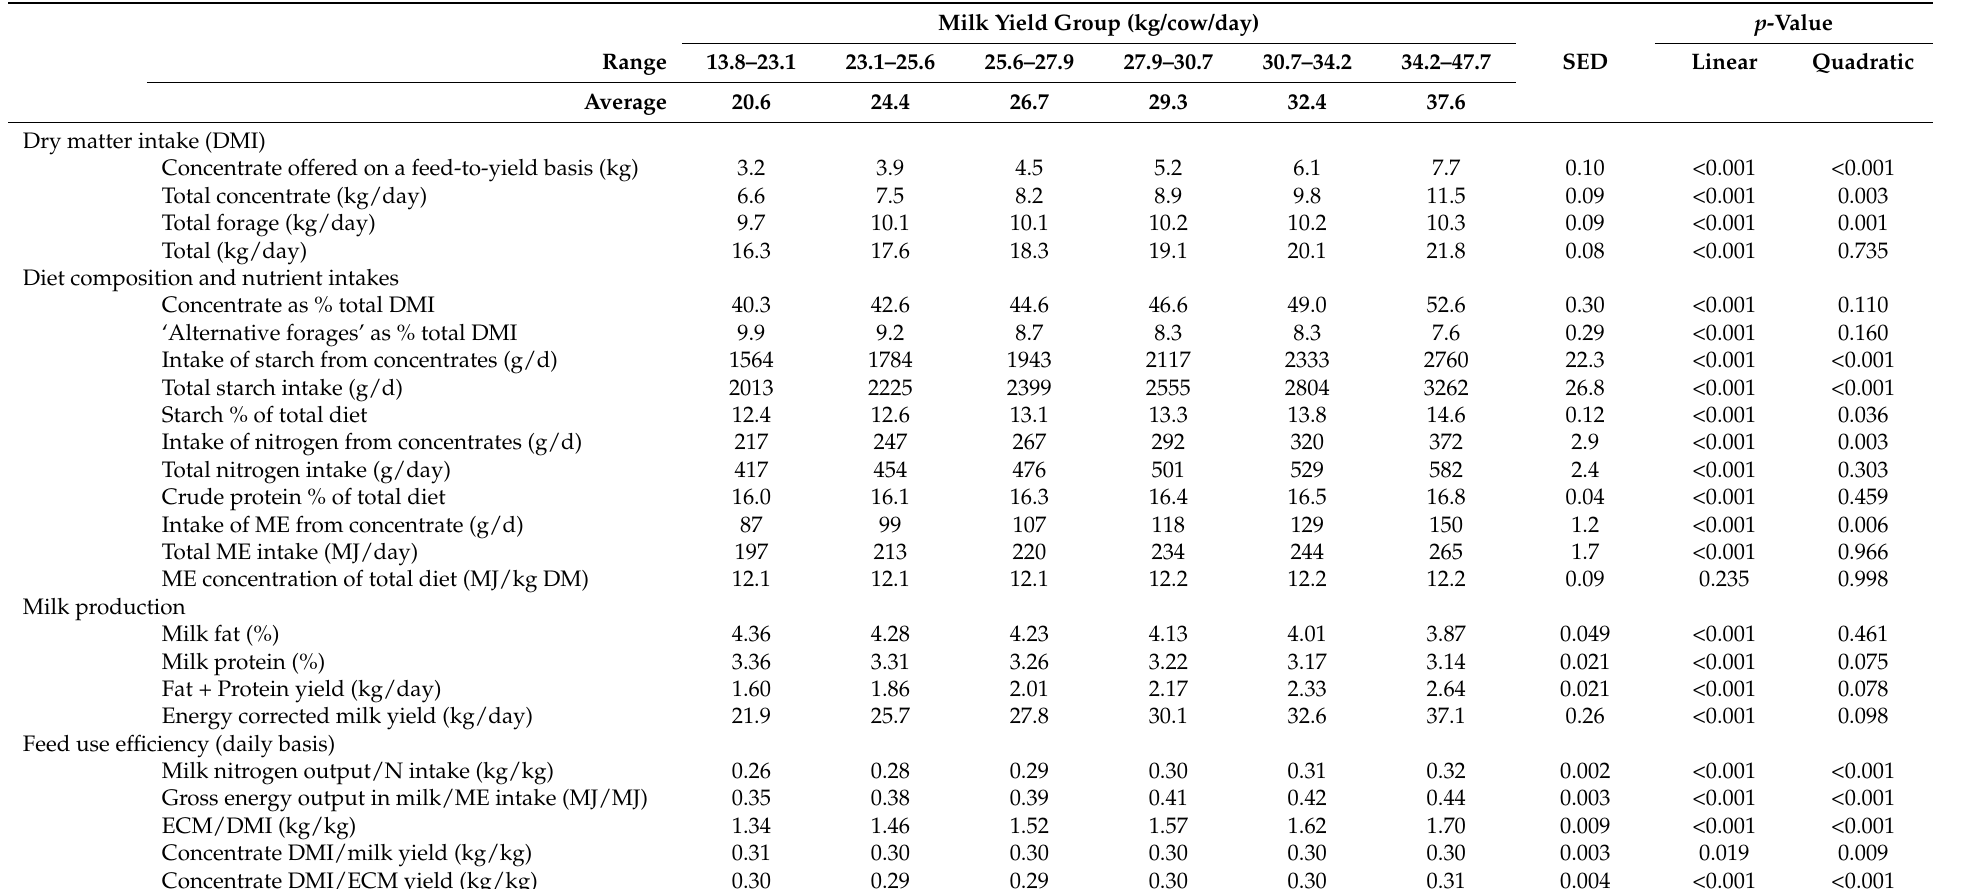
Table 2. Dry matter intakes, nutrient intakes and diet composition, milk production, and efficiency values within each milk yield group for first lactation cows. Milk Yield Group (kg/cow/day) p